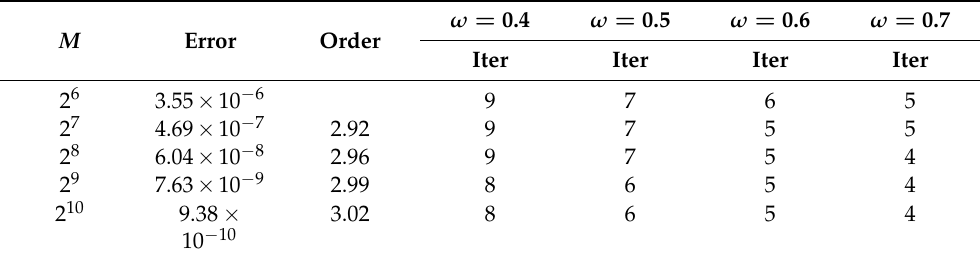
Table 7. L 2 errors for (84) with different ω by the third-order scheme. M Error Order